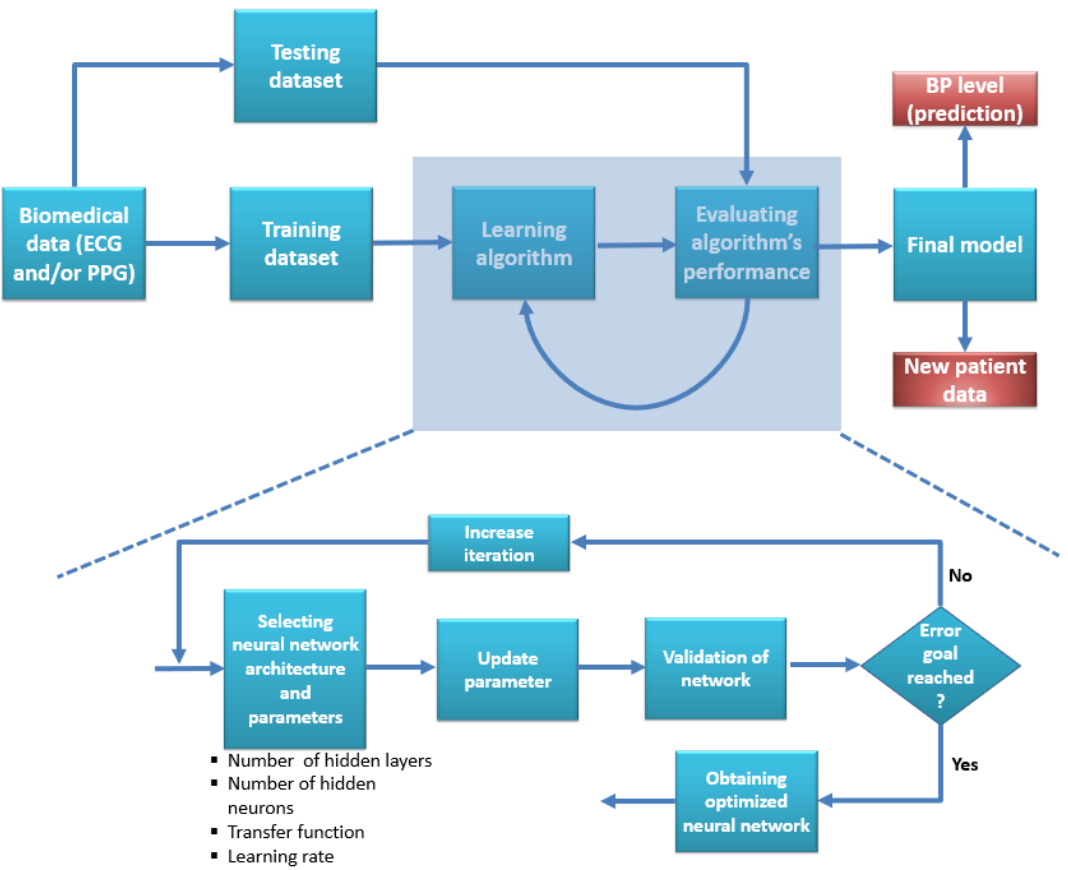
Figure 9. An example of a deep learning network flow diagram.